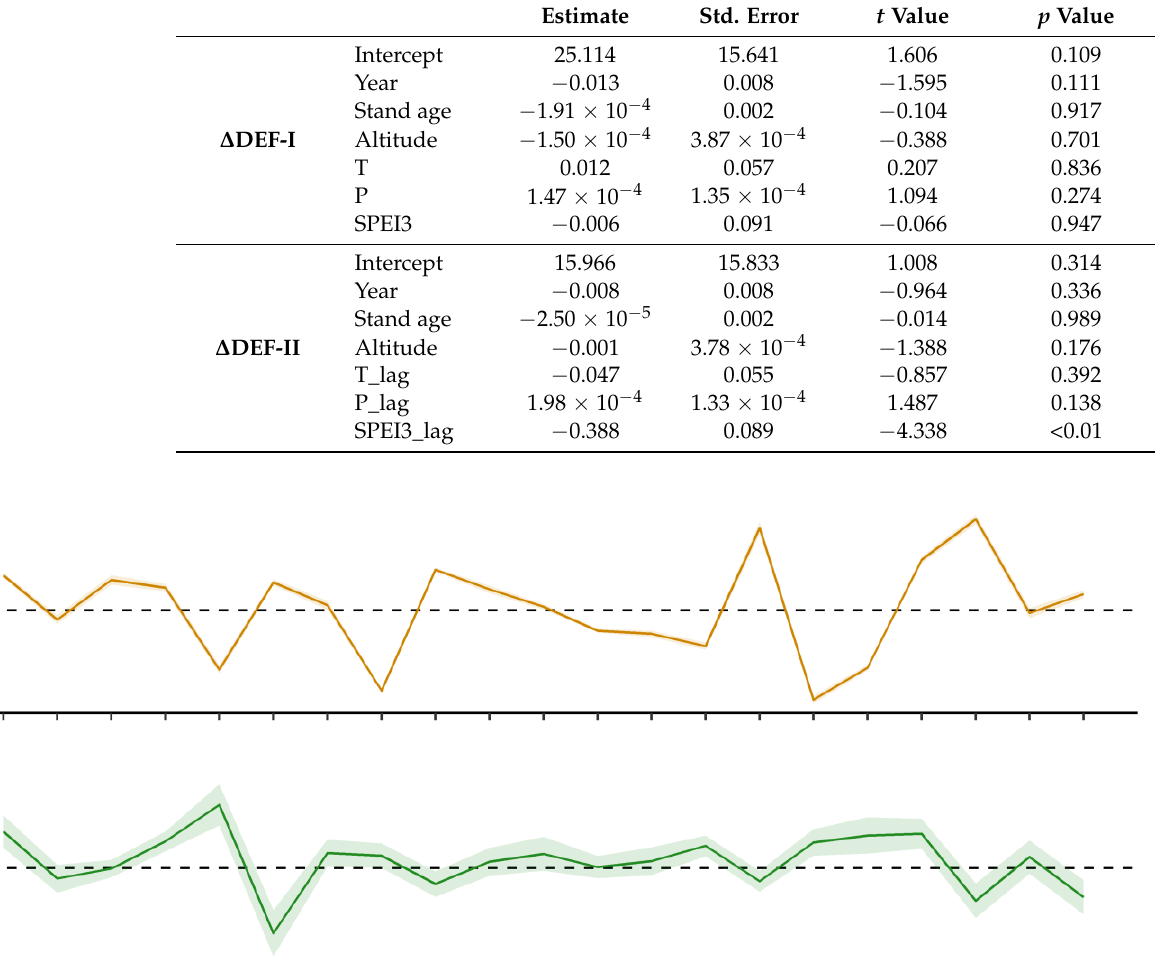
Table 3. Estimated regression parameters, standard errors, t -values, and p -values for mean defoliation